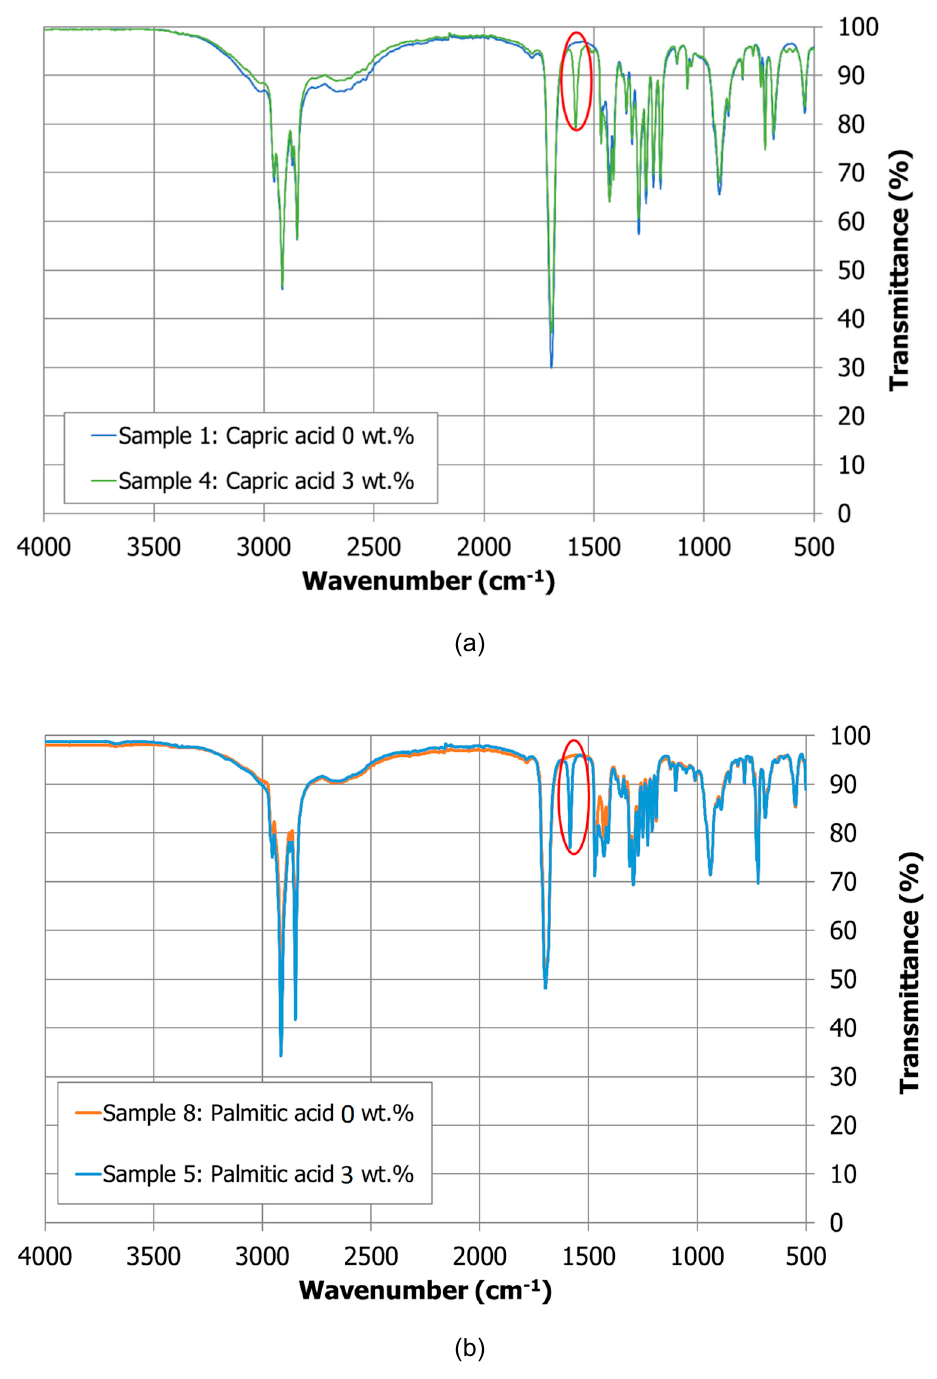
Figure 3. FT-IR spectra of capric acid ( a ) and palmitic acid ( b ) samples under study. Viscosity: Figure 4 shows the viscosity of the capric acid samples under study. There is a slight increment of the viscosity with the nanoparticles content, as expected. This fact will promote the NEPCM stability in terms of nanoparticles sedimentation.